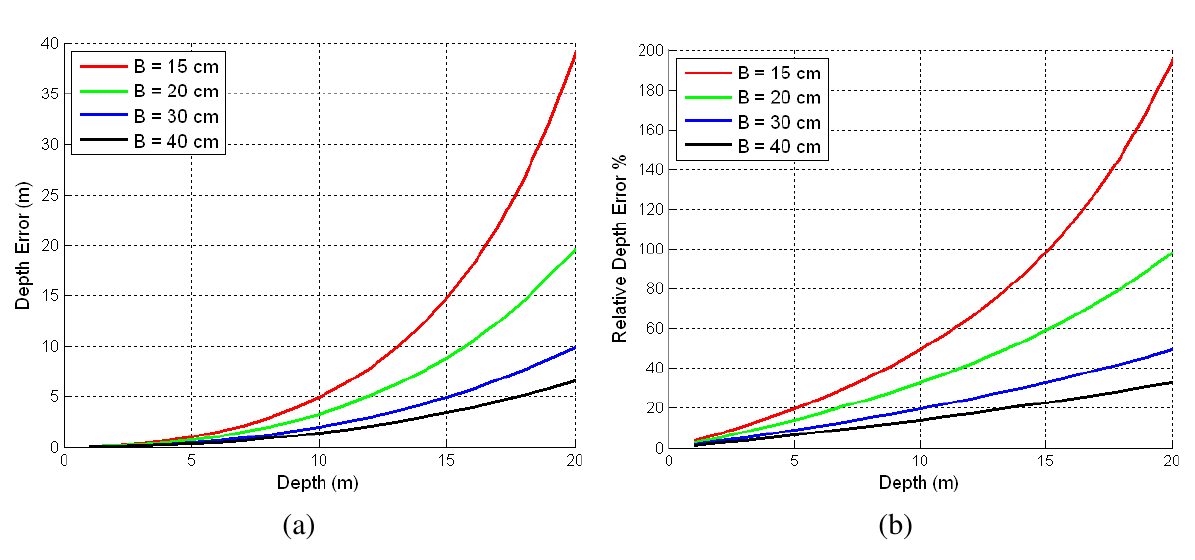
Figure 3. (a) Absolute and (b) relative depth estimation errors for a stereo rig considering a = 202 pixels and image size 320 £ 240 , for different focal length f x